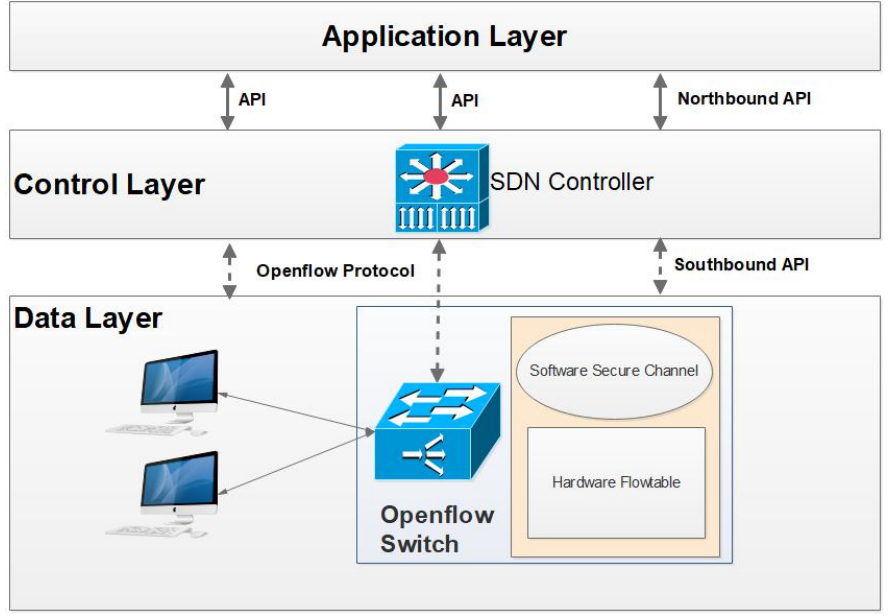
Figure 1. SDN Architecture.